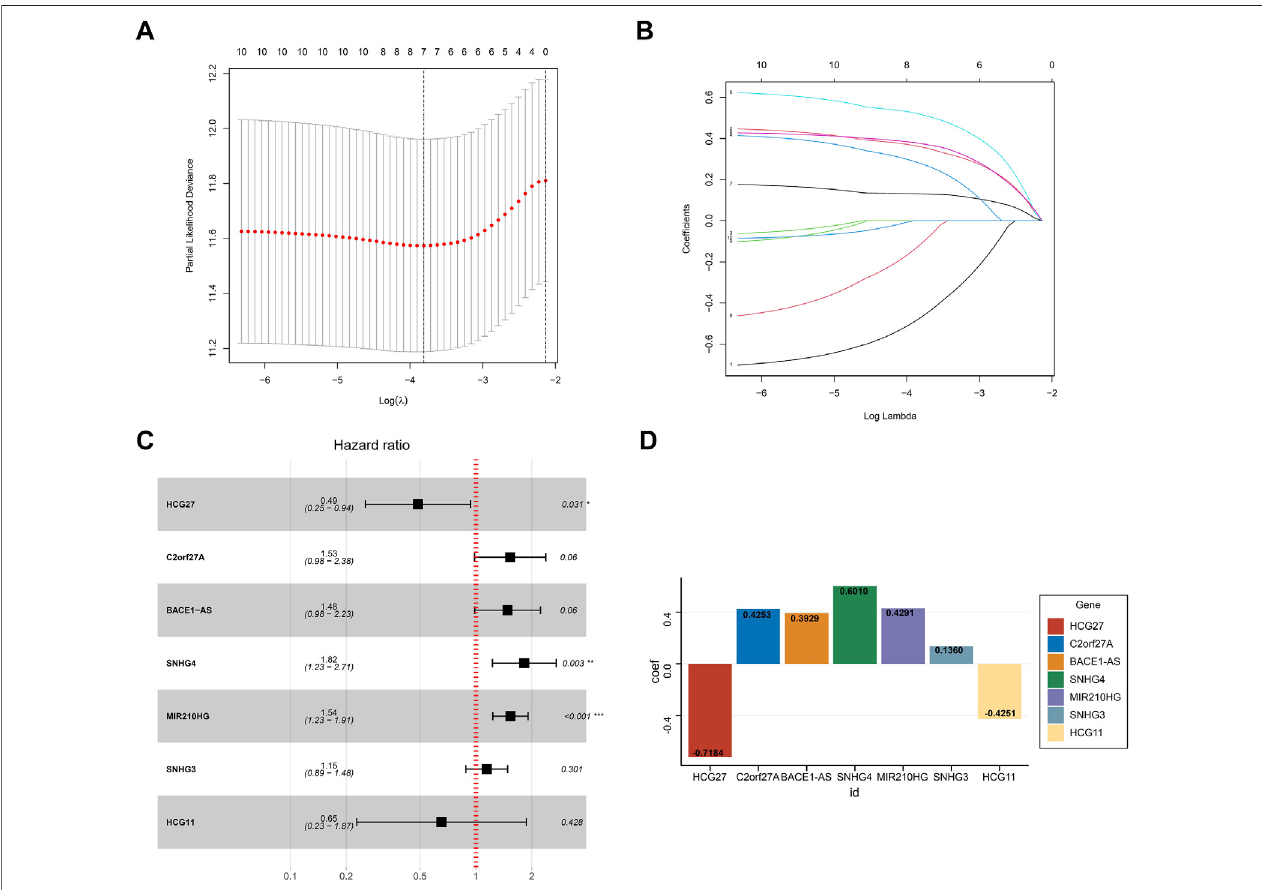
FIGURE4| Constructionoftheprognosticsignature. (A) TheLASSOcoef fi cientpro fi lesofsevenNRLs. (B) Theten-foldcross-validationforvariableselectioninthe LASSO model. (C) Multivariate Cox analysis of the seven NRLs (ENTER method). (D) The regression coef fi cient of the seven NRLs in the signature.